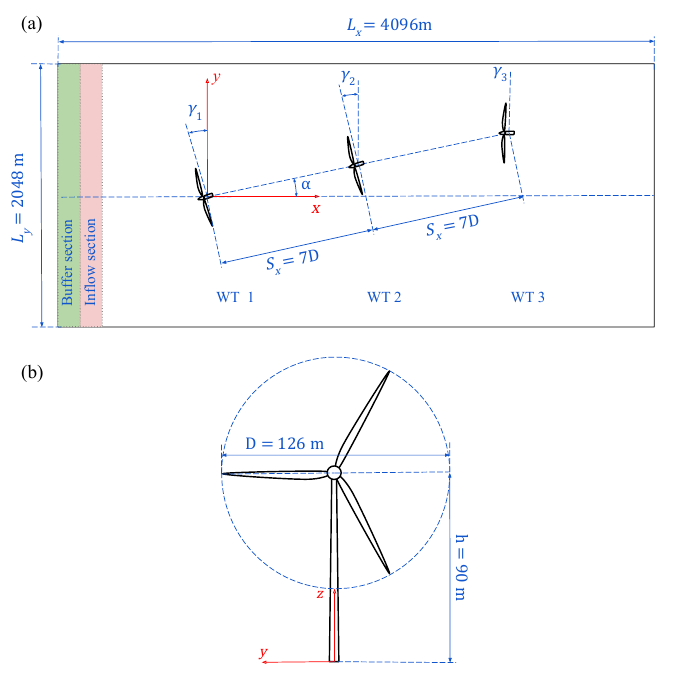
Figure 3. Schematic plots (not to scale) of ( a ) the simulation domain and ( b ) NREL 5MW reference wind